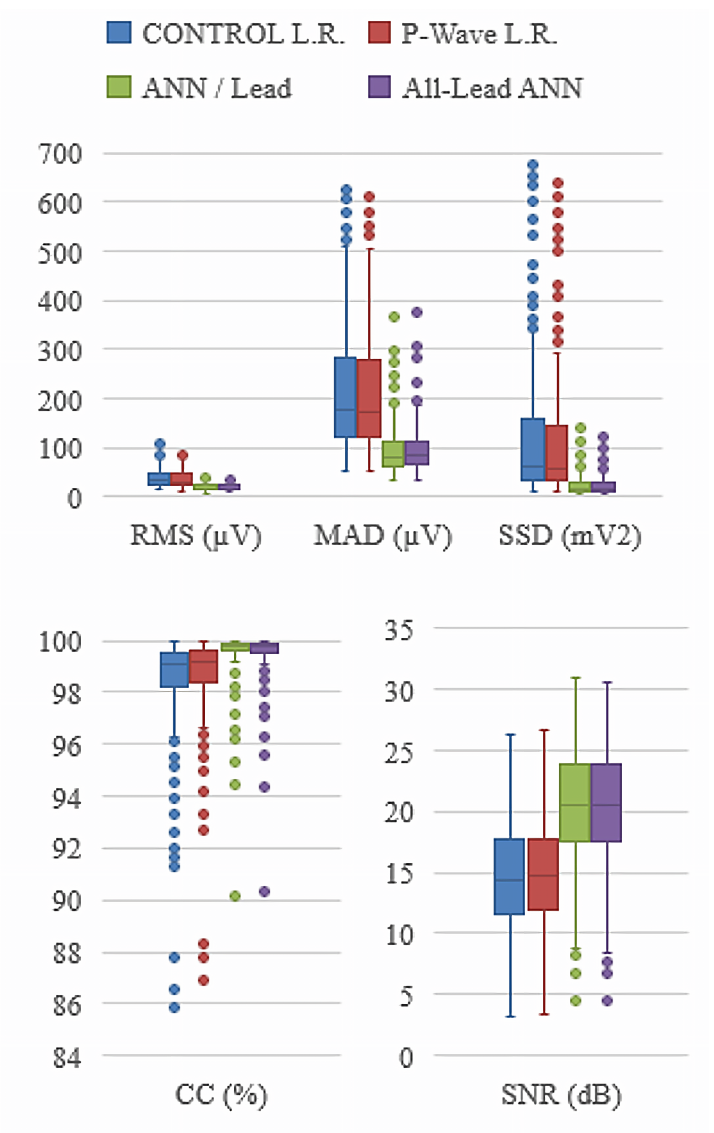
Figure 7. Boxplot graphical representation of the five FoMs for each of the four ECG reconstruction methods studied. The results for both Linear Regression methods are represented in blue and red for the simple Linear Regression method and the P-wave segmentation method, respectively. The ANN strategies are represented in green and purple for the ANN/lead and the unique ANN methods, respectively. The parameters have been divided into three graphs to facilitate their visualization and